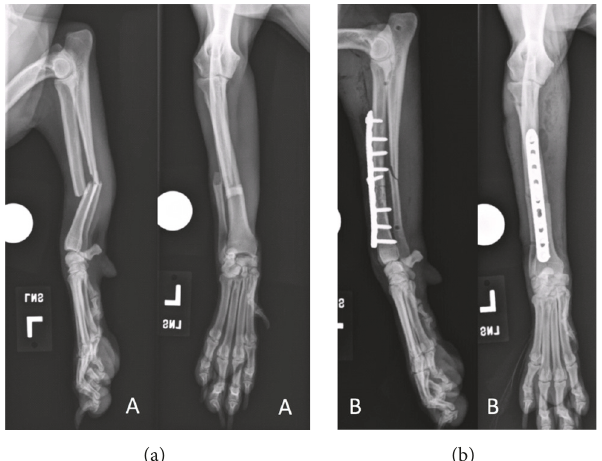
Figure 2: Craniocaudal and mediolateral preoperative radiographs of dog #1’s left radius and ulna fractures (a). Initial postoperative radiographs following primary surgical stabilization with a 9-hole, 2.7 mm locking compression plate (b).